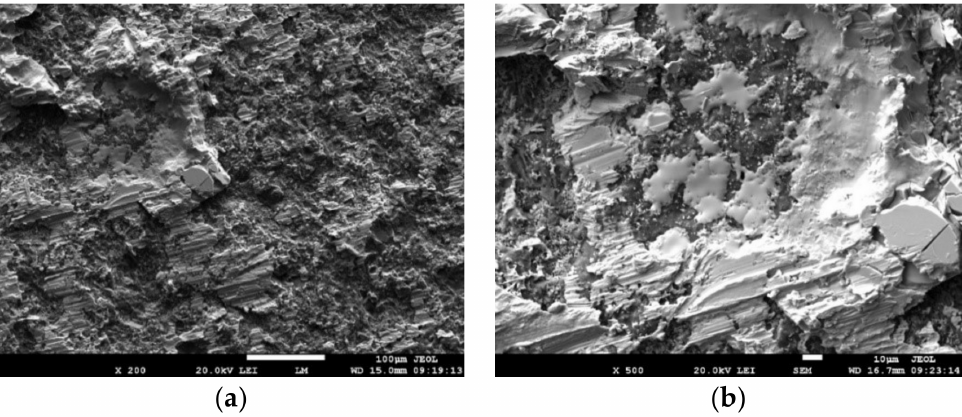
Figure 21. Fractured surface of soldered joint of SiC/Sn5Sb3Ti/Ni; ( a ) magnification 200 × ; ( b ) magnification 500 ×